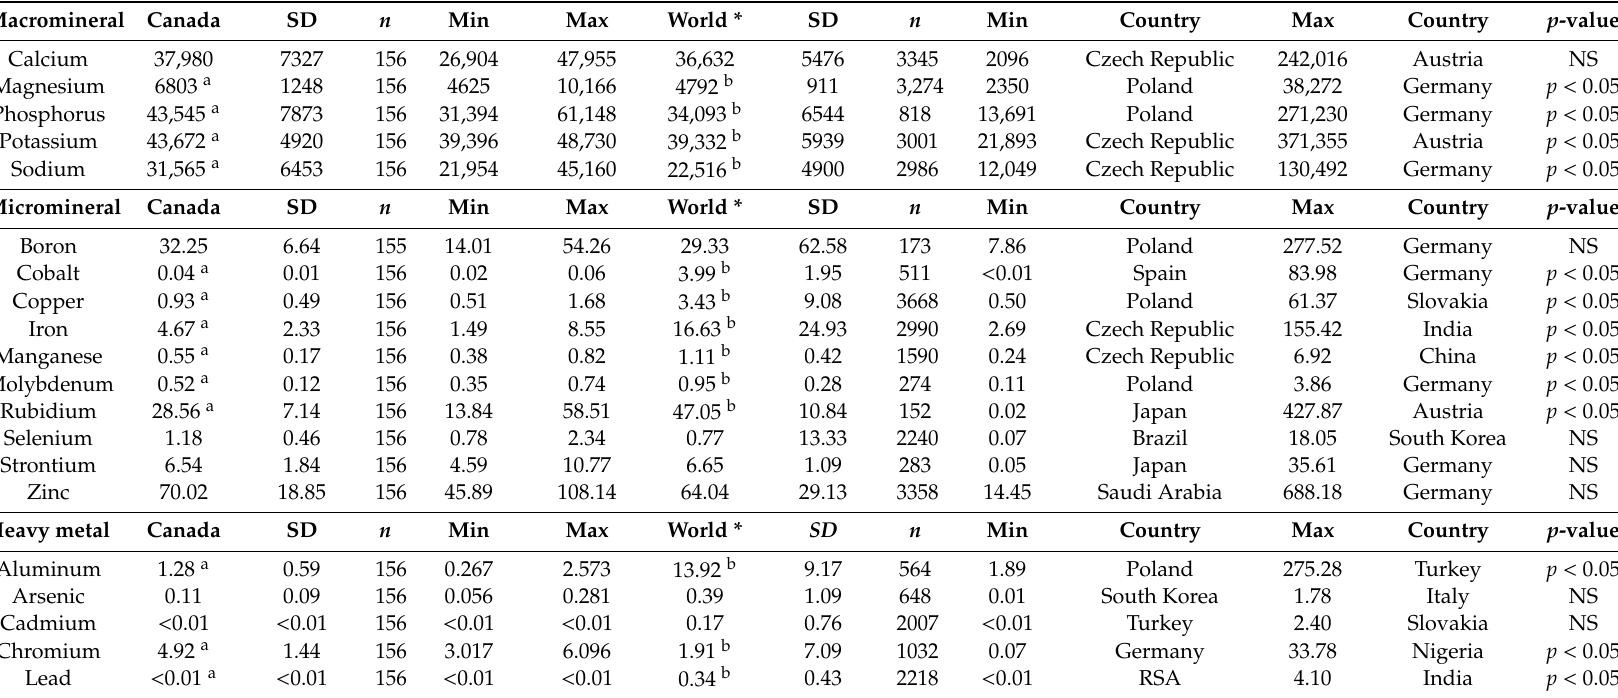
Table 2. Concentration of macro- and microminerals as well as heavy metals in the raw milk of dairy cows in Alberta, Canada compared with the respective World